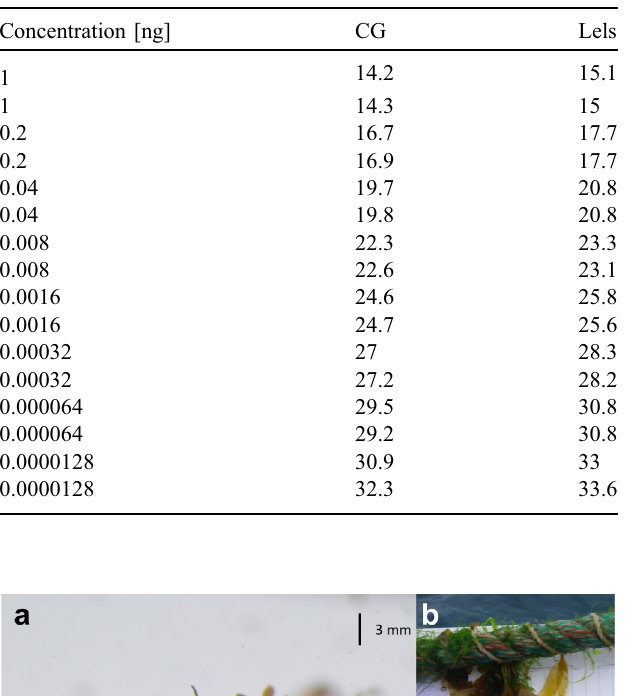
Table 2. Number of qPCR quanti fi cation cycles obtained from L. elsbetiae DNA using the general (CG) and endophyte speci fi c (Lels) primer pair.